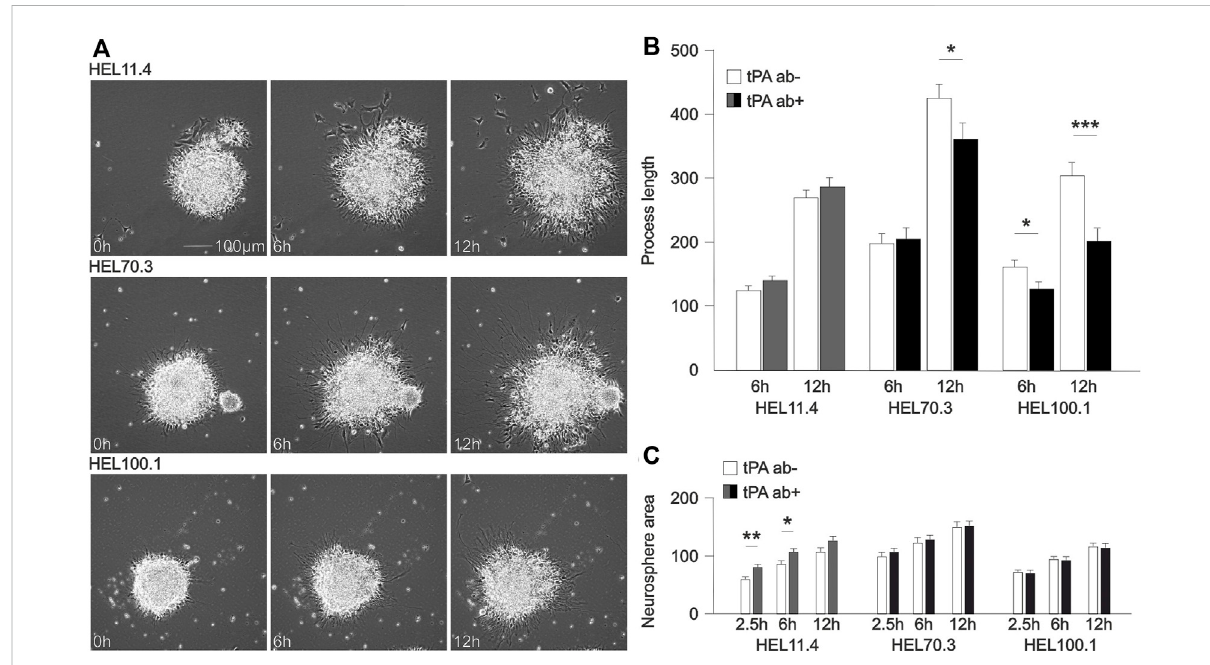
FIGURE 3 Tissueplasminogenactivator(tPA)-mediatedeffectsdownstreamofLYNX1oncellularprocessgrowth. (A) Representativetime-lapseimagesof neurospheres derived from control ( HEL11.4) and FXS (HEL70.3 and HEL100.1) iPSC lines. Video clips of representative untreated and treated neurospheres derived from each cell line are shown in Supplementary Materials. (B) Distance extended by the furthest reaching cellular process emanating from control (HEL11.4) and FXS (HEL70.3 and HEL100.1) neurospheres 6 h and 12 h after plating on matrix in medium without mitogensallowingprogenitordifferentiation.Thenumberofanalyzedneurospheresinseparatecultures(n)without/withtPAabtreatment:HEL11.4: 59 ( n = 5)/70 ( n = 5); HEL70.3: 34 ( n = 3)/29 (n = 3); HEL100.1: 67 (n = 9)/29 (n = 4). (C) Neurosphere core size in control (HEL11.4) and FXS (HEL70.3 and HEL100.1) neurospheres 2.5 h (at the initiation of recording), 6 h, and 12 h after plating without and with tPA ab treatment. Human tPA ab (200 ng/ml) was added at the beginning of the differentiation as indicated (dark gray in control; black in FXS). Results are shown as mean ± SEM. Signi fi cances were determined with the Student ’ s t -test. * p < 0.05, ** p < 0.01, *** p <